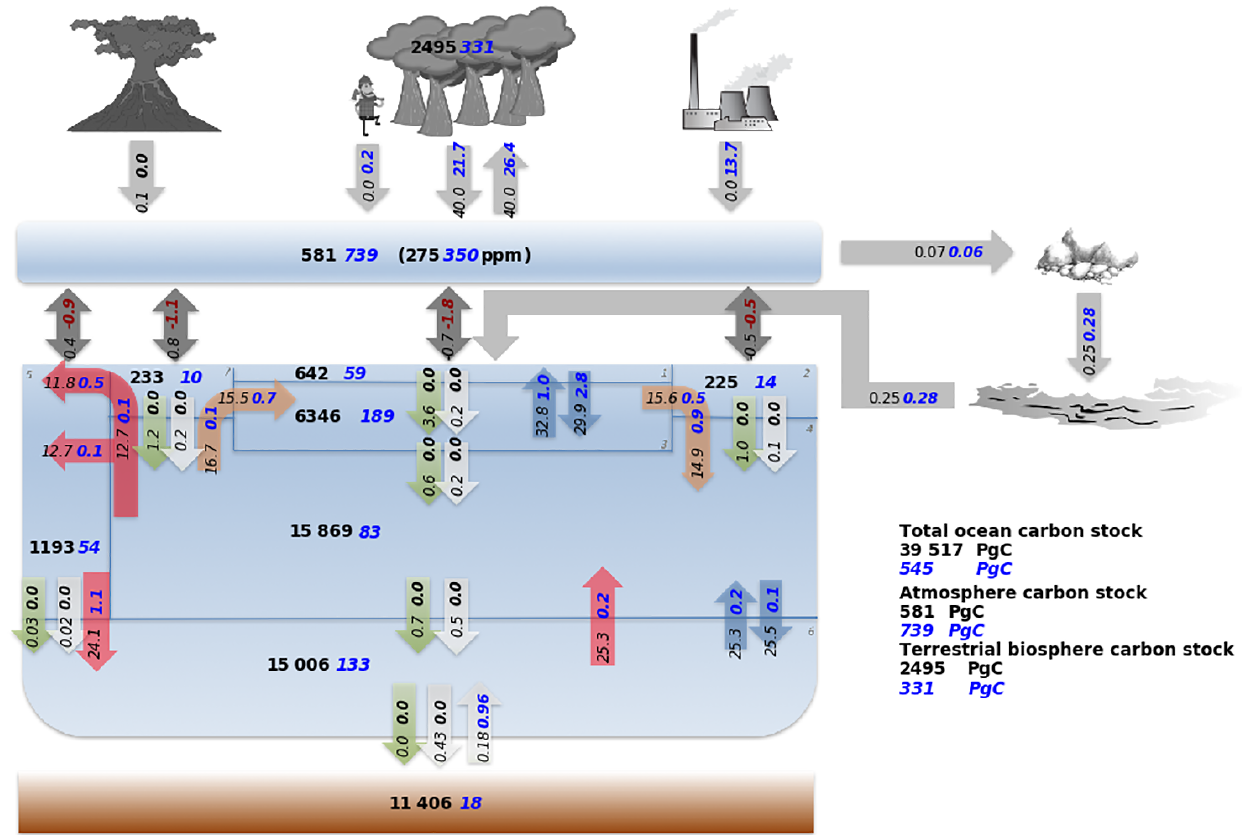
Figure 9. SCP-M-modelled pre-industrial carbon stocks and fluxes (in PgC in black text) compared with IPCC RCP6.0 emissions scenario by 2100 (shown asPgC changes with blue text for positive changes, red text for negative and black text for no change). Atmosphere, ocean and terrestrial biospheres take up the load of carbon from the industrial source. By 2100, carbon is fluxing into all ocean boxes, the terrestrial biosphere and continental sediment weathering–river fluxes. Pre-industrial outgassing of CO 2 in the Southern Ocean is reversed, and carbon is returned to the ocean via enhanced CaCO 3 dissolution. Box numbers on the diagram refer to ocean regions specified in Fig. 1. Negative fluxes on bidirectional air–sea exchange arrows are fluxes of CO 2 out of the atmosphere into the